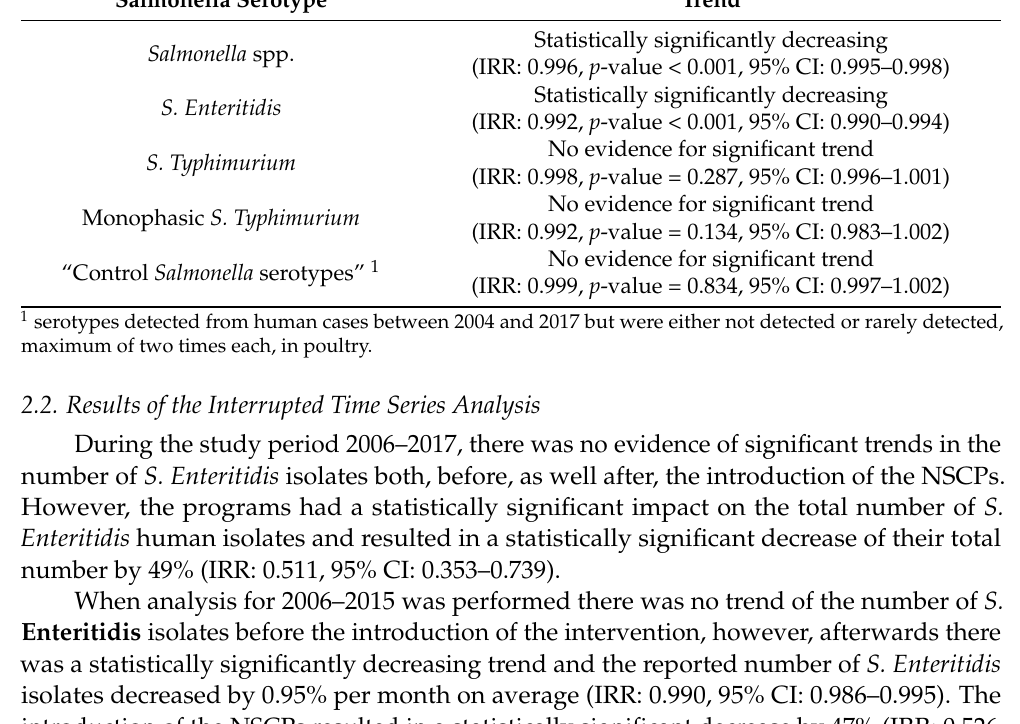
Table 2. Results of the evaluation of the impact of the introduction of the National Salmonella Control Programmes (NSCPs) on the trend and total number of S . Enteritidis , S . Typhimurium and “Control Salmonella serotypes” of human isolates.